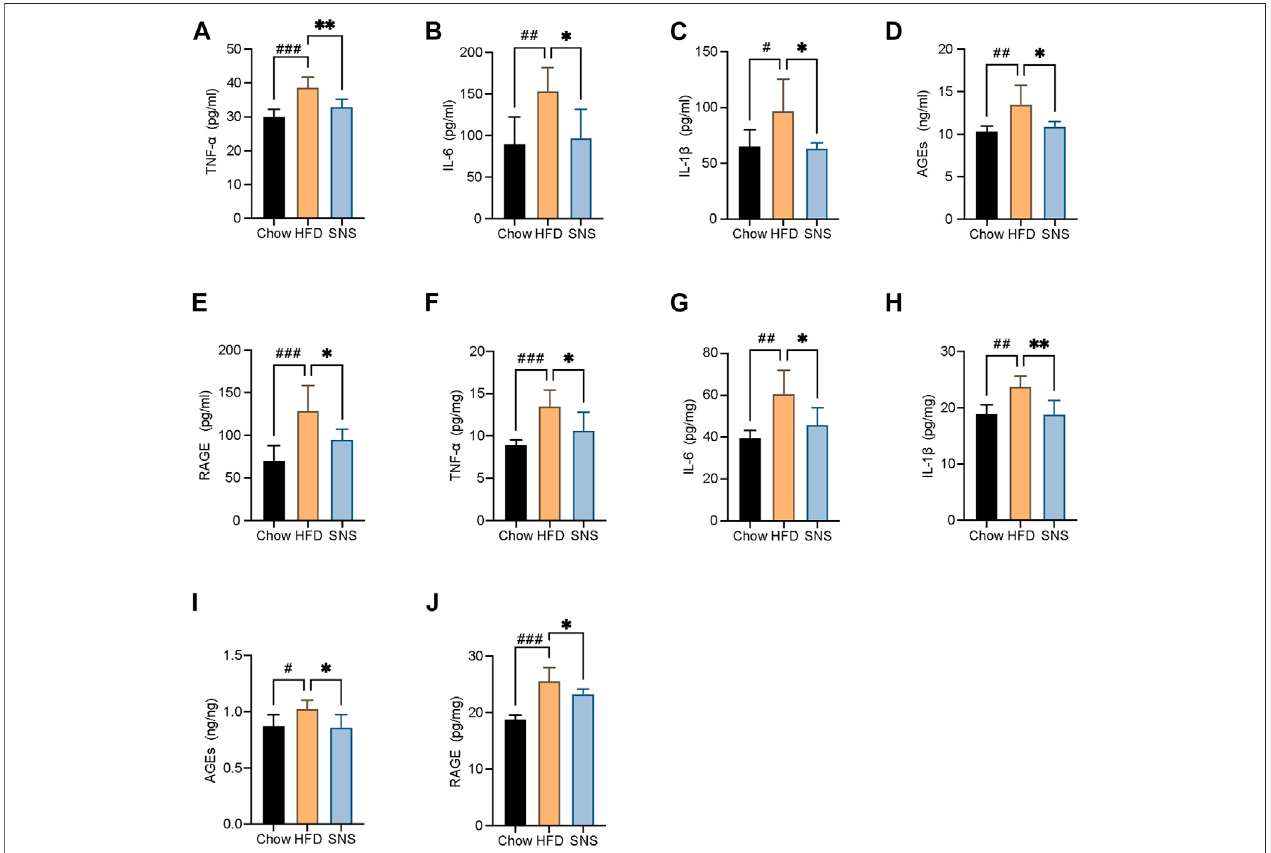
FIGURE 8 | SNS reduced liver pro-in fl ammatory cytokines, advanced glycation end-products (AGEs), and its receptor. (A) Serum levels of tumor necrosis factor alpha(TNF α ). (B) Serumlevelsofinterleukin6(IL6). (C) Serumlevelsofinterleukin1 β (IL1 β ). (D) SerumlevelsofAGEs. (E) Serumlevelsofreceptorforadvancedglycation end-products (RAGE). (F) Liverlevels ofTNF α . (G) LiverlevelsofIL6. (H) LiverlevelsofIL1 β . (I) LiverlevelsofAGEs. (J) Liverlevels ofreceptor forRAGE.Dataareshown as mean ± SD (n (cid:2) 6). # p < 0.05, ## p < 0.01, ### p < 0.001 when compared with the Chow group, * p < 0.05, ** p < 0.01, *** p < 0.001 when compared with the HFD